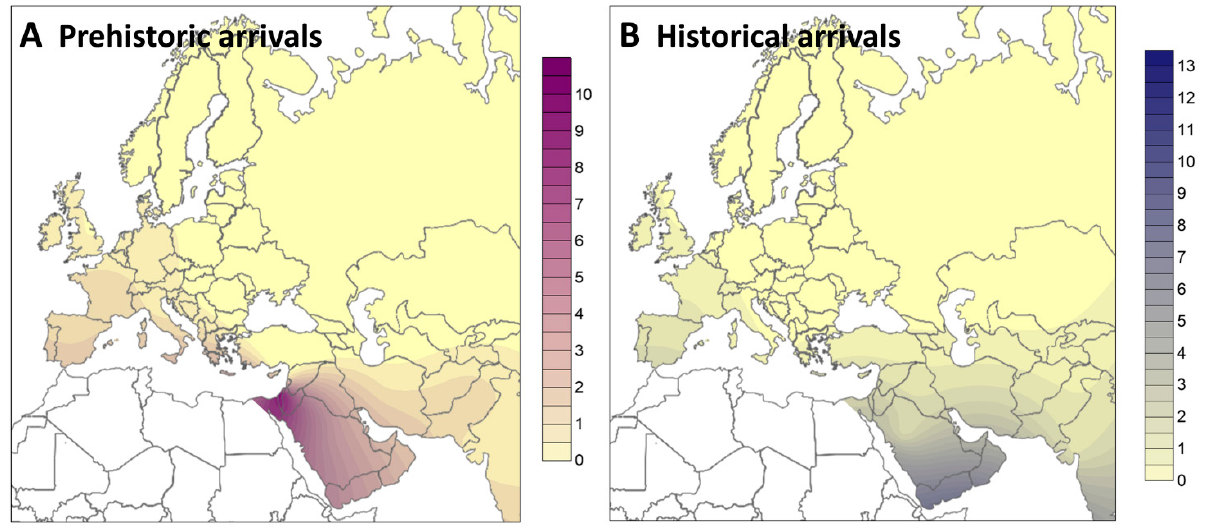
Figure 3. Frequency of sub-Saharan lineages in Europe and Southwest Asia following the statistical allocation into prehistoric arrivals ( A ) and historical arrivals ( B ). Plots estimated using the Kriging algorithm of the Surfer 8 software.